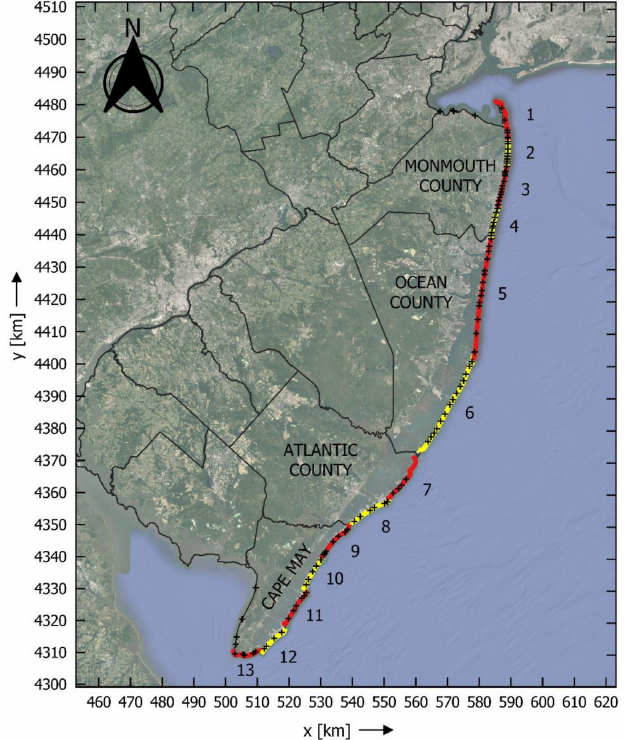
Figure 1. Study area location. Alternating red and yellow lines depict NJ Shoreline Segments utilized by Lemke and Miller [38] to produce the storm erosion potential climatology. Segments are numbered from north to south with #1 at Sandy Hook and #13 at Cape May. NJ coastal are counties labeled accordingly. Black + markers depict NJBPN survey locations. Map coordinate system is NAD83/UTM Zone 18N in kilometers. Courtesy of [20].